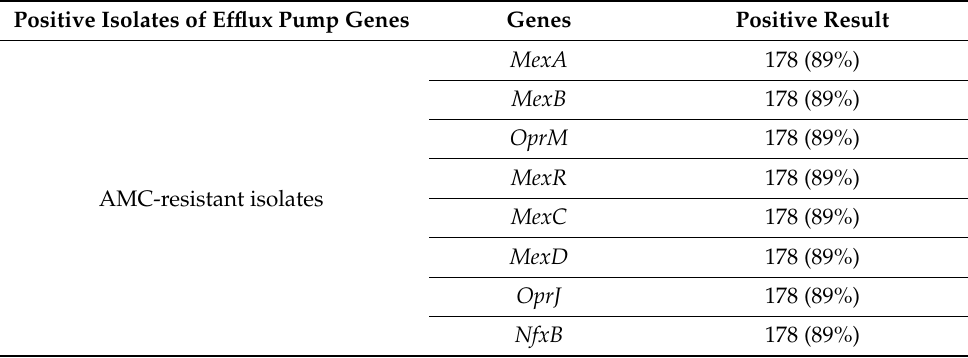
Table 6. Polymerase chain reactions of Antibiotic resistance efflux pump genes.